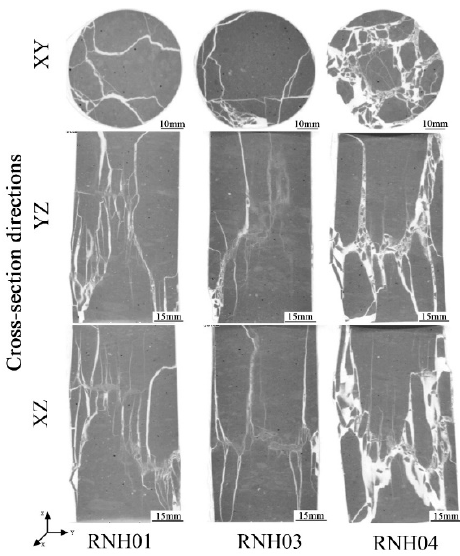
Figure 11. Three corresponding views of the weakly welded tuff specimens were scanned with a linear accelerator CT. From top to bottom, the cross-sections are of the X-Y plane (parallel to the bottom of the sample), the Y-Z plane, and the X-Z plane, respectively.